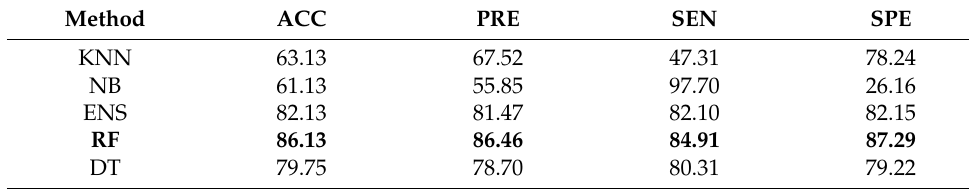
Table A4. AF detection performance based on CTW–RQA features ( n = 2).